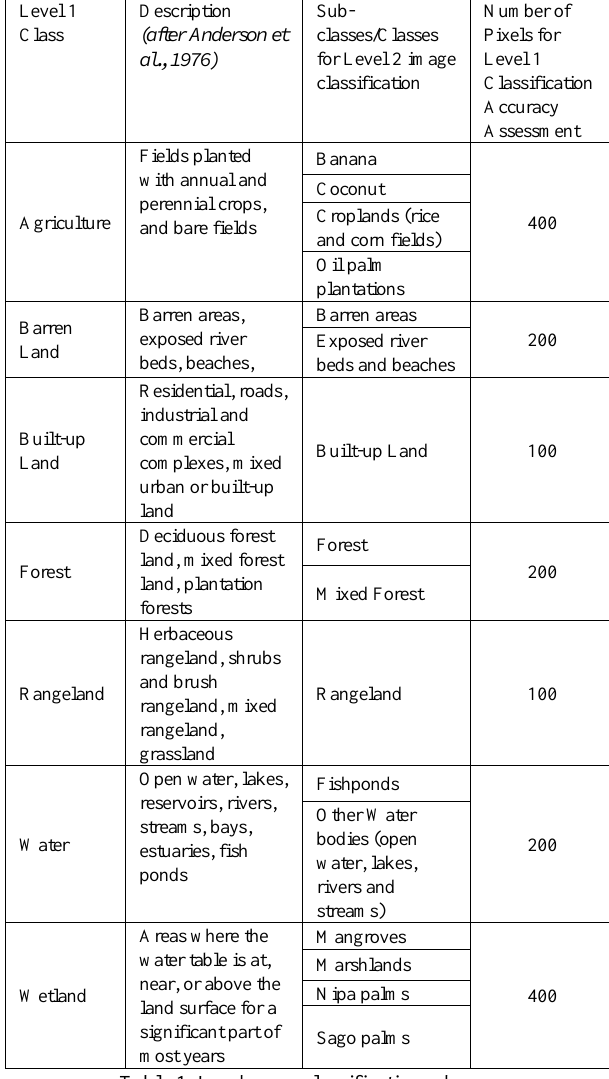
Table 1. Land cover classification